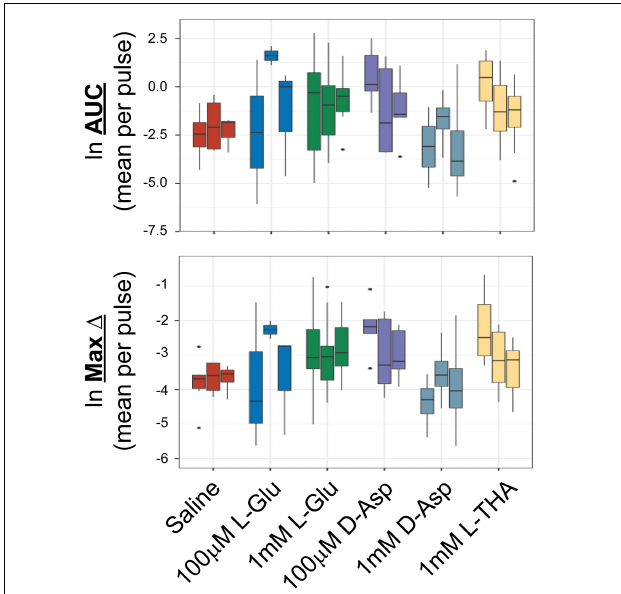
FIGURE 1 | Effects of saline or glutamate transporter substrates on arteriole diameter. Saline, L-glutamate, D-aspartate, or L-THA were picospritzed near cortical arterioles. The area of the largest dilation and the maximum change were measured as described in the text. The original data were the mean values for each animal. The median is indicated by the horizontal line and the interquartile range (25 th to 75 th percentile) by the box. The whiskers are 1.5 times the interquartile range, added or subtracted to the percentiles, and drawn back to the nearest point. Values outside of the whiskers are outliers (dots). The data for saline are from 6 animals (3 male,3 female), the data for 100 µ M L-Glu are from 3 animals (1 male, 2 females), the data for 1 mM L-Glu are from 12 animals (12 males), the data for 100 µ M D-Asp are from 5 animals (3 males, 2 females), the data for 1 mM D-Asp are from 4 animals (4 males), the data for 1 mM L-THA are from 11 animals (7 males, 4